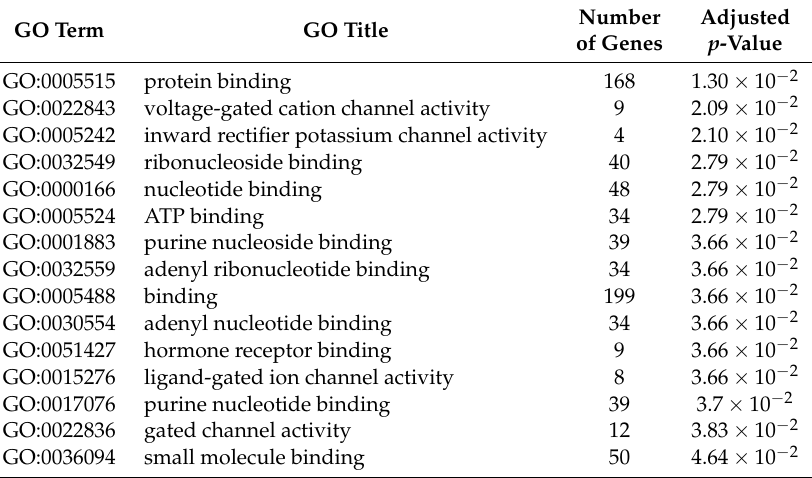
Table 2. Top 15 Gene Ontology (GO) molecular function terms based on the adjusted p -value for the eggshell strength at Time Point 2